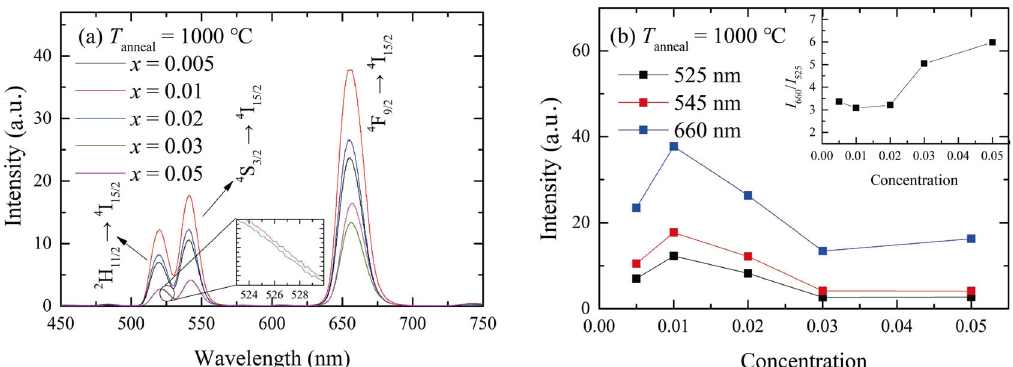
Fig. 8 (a) UC emission spectra of the x = 0.005, 0.01, 0.02, 0.03, and 0.05 NCs annealed at 1200 ℃ under the λ ex = 980 nm photoexcitation. (b) Emission intensities at 525, 547, and 660 nm of the NCs annealed at 1200 ℃ as a function of the Er 3+ concentration. Inset of Fig. 8(a) is the enlarged spectra in the range of 523–530 nm and inset of Fig. 8(b) is the intensity ratios of the 660 nm to 525 nm emissions as a function of the Er 3+ concentration ( x